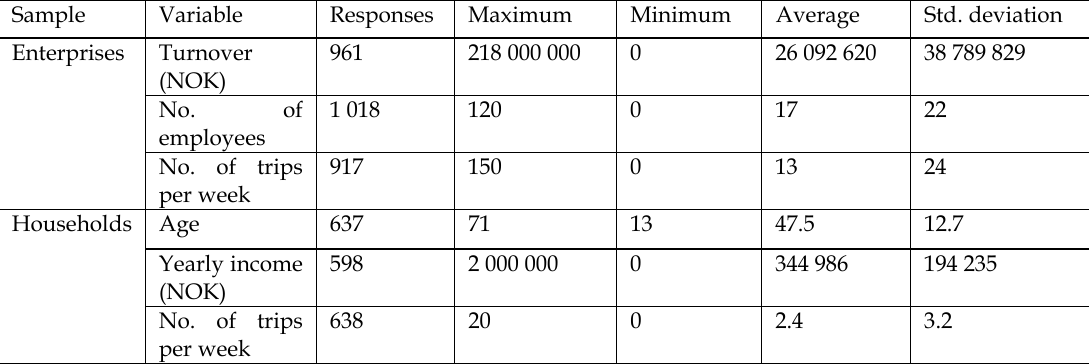
Table 3. Descriptive statistics for the two data